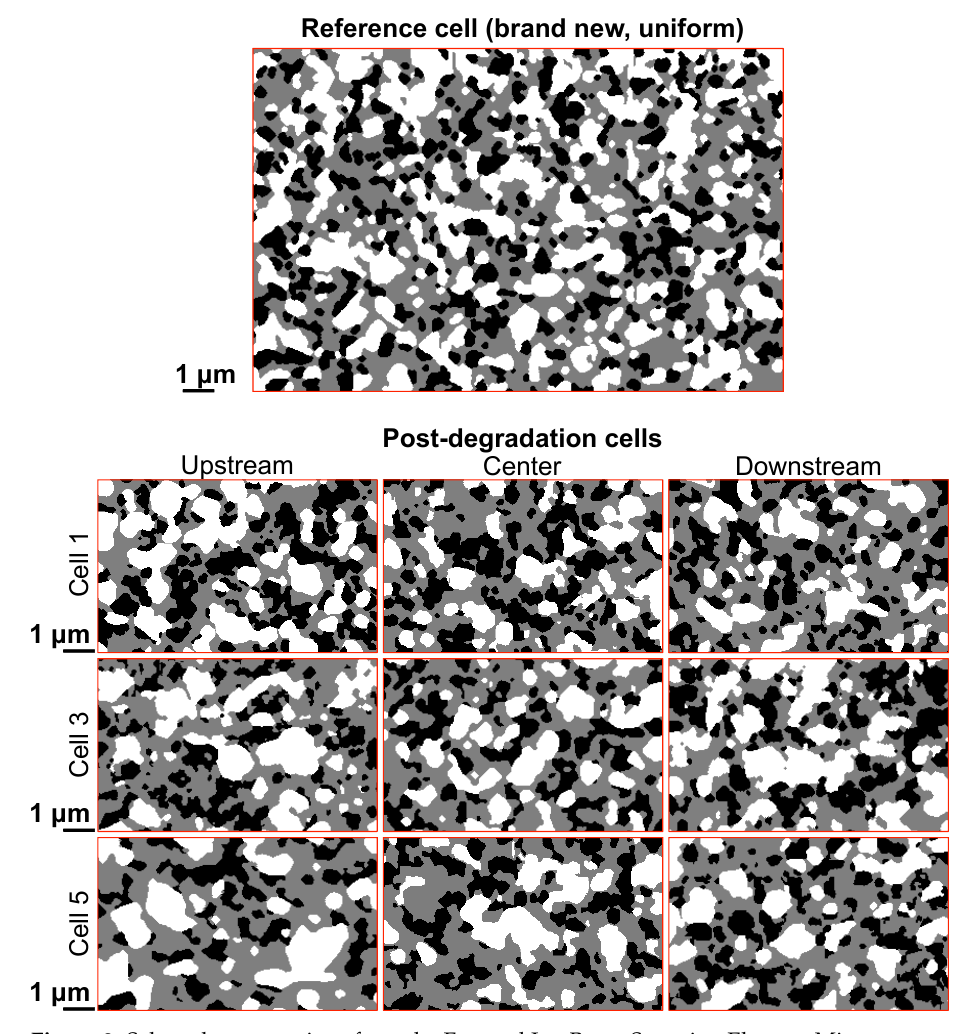
Figure 2. Selected cross sections from the Focused Ion Beam Scanning Electron